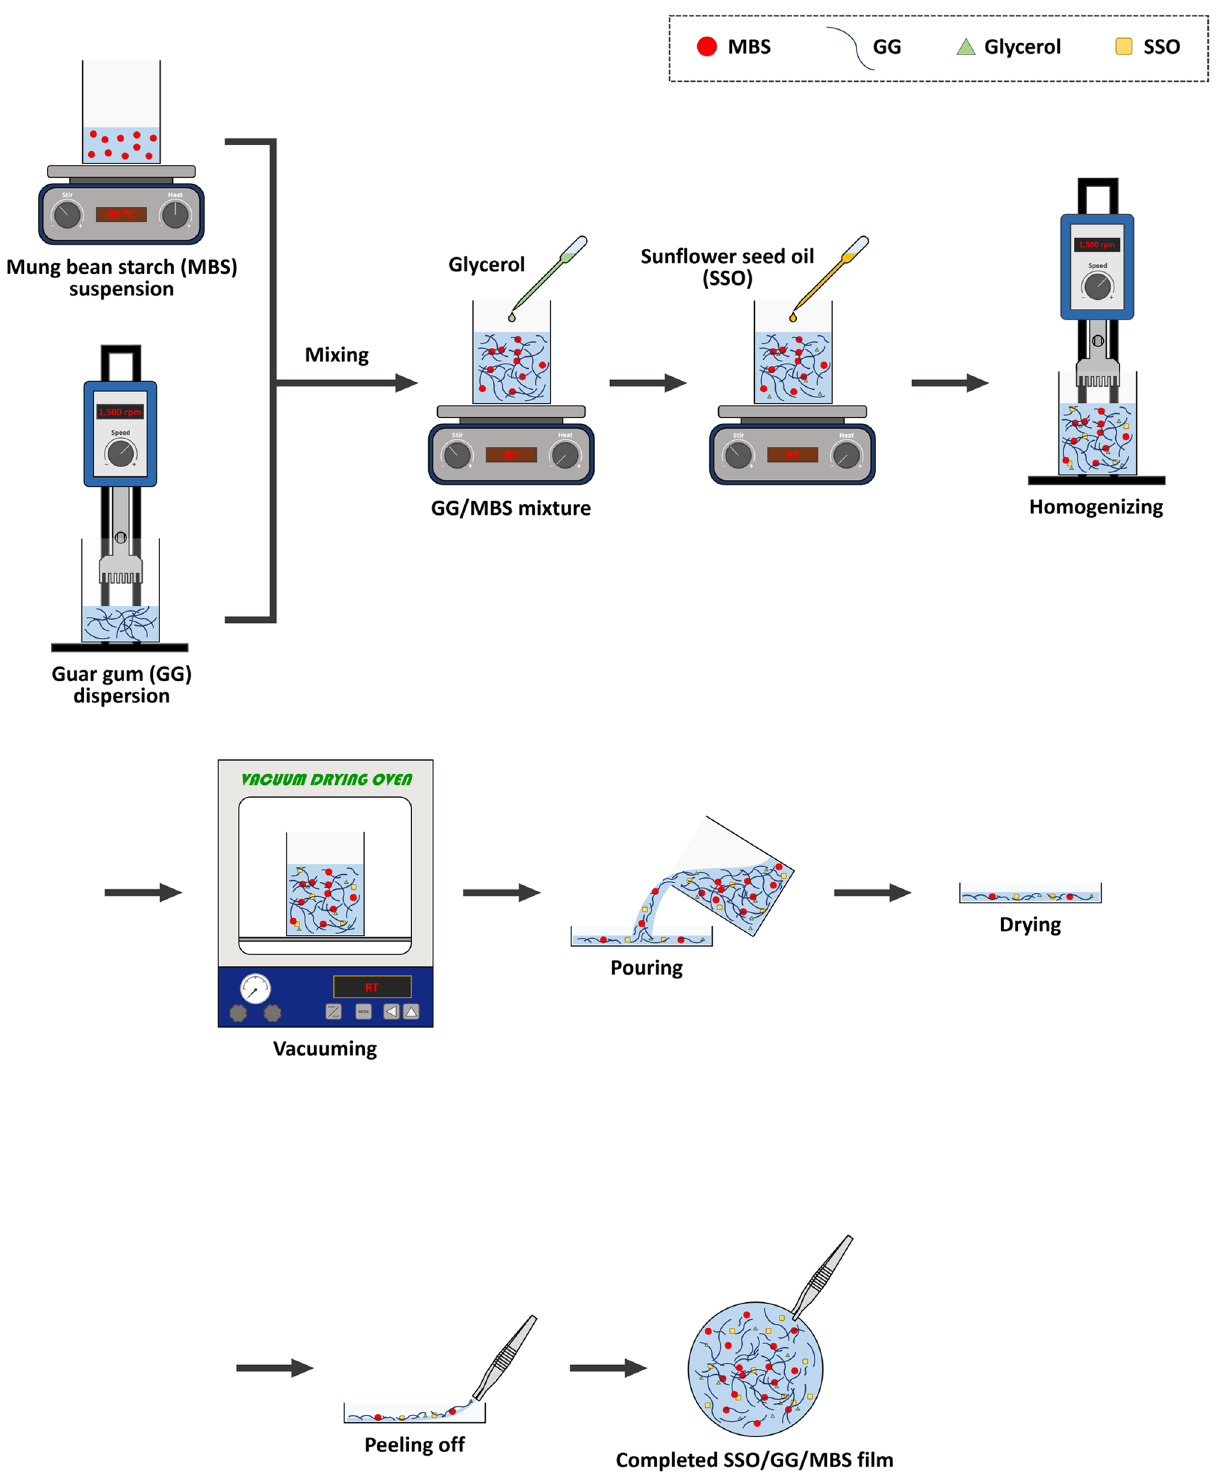
Figure 1. Scheme of the procedure to prepare SSO/GG/MBS composite films. GG guar gum, MBS mung bean starch, SSO sunflower seed